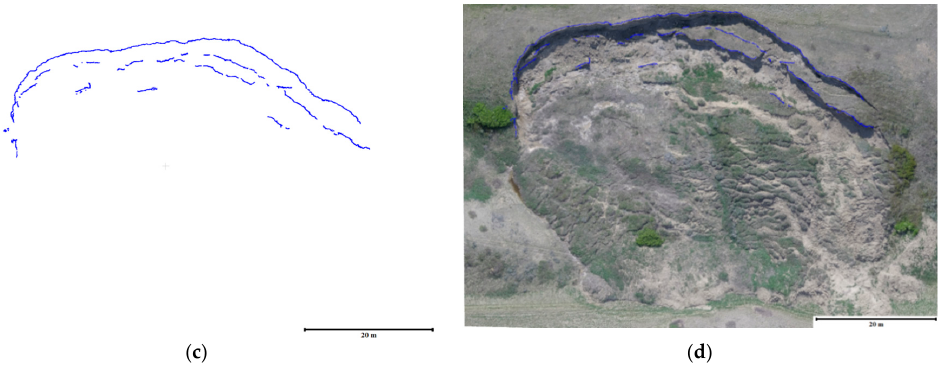
Figure 16. Extracted landslide scarps using eigenvalue ratio ( λ 1 / λ 2 ≥ λ 3 ) computed using the dense 3D image-based point cloud dataset collected in May 2015 for the study landslide, Lethbridge, Alberta. ( a ) Eigenvalue ratio ( λ 1/ λ 2); ( b ) extraction of landslide scarp features based on variation in the local topography’s eigenvalue ratio; ( c ) final landslide scarp detection results based on eigenvalues ratios of the topographic surface index; ( d ) scarps overlaid on the orthophoto using UAV images of the study area.